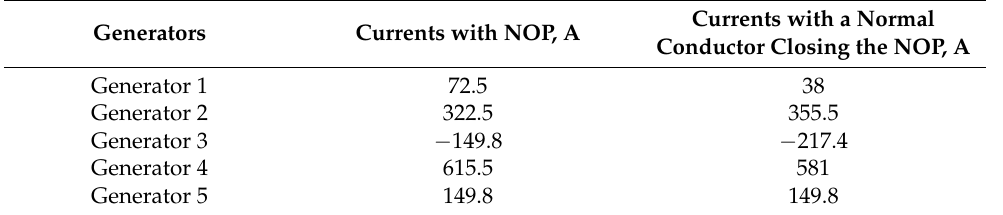
Table 5. Comparison between the performance of the DCSOP and the normal conductor in terms of the change of generator